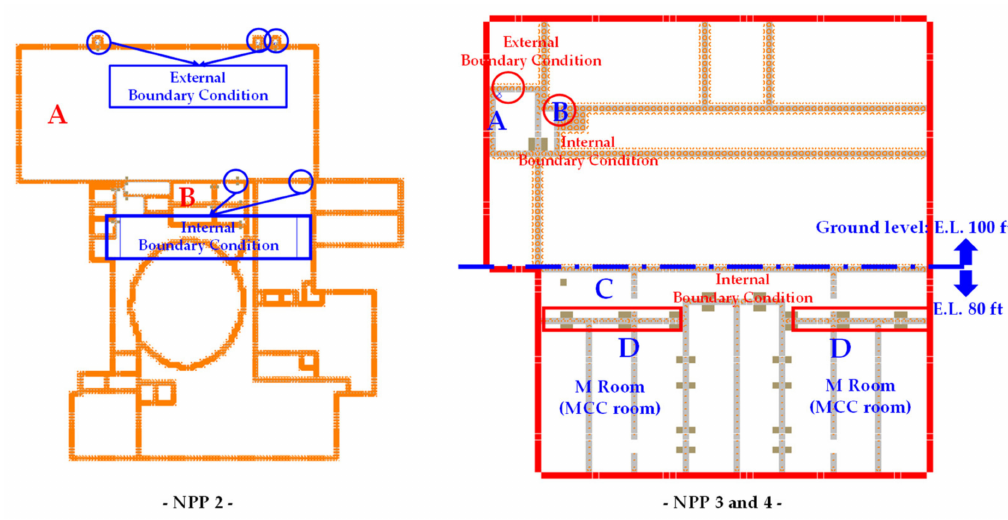
Figure 9. 2D modeling for internal flood